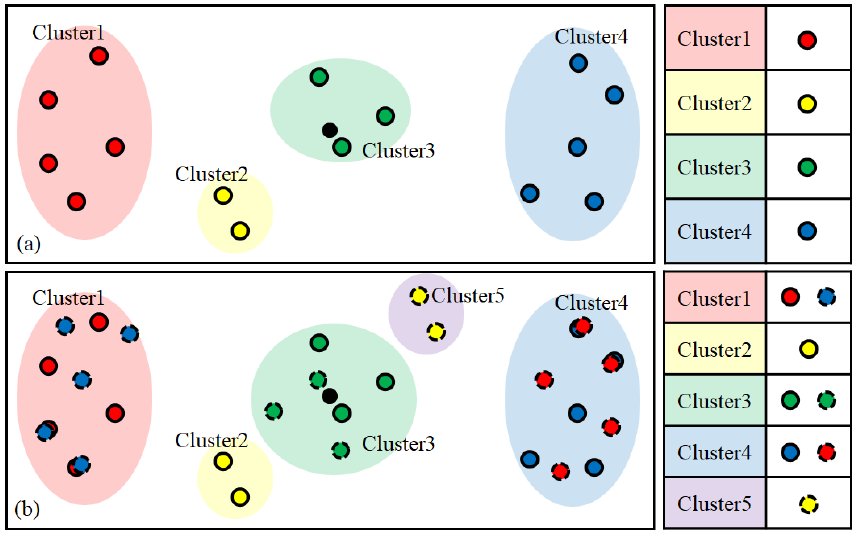
Figure 5. Clustering results of ( a ) original data and ( b ) data including both the original data and symmetric data (dotted circles indicate symmetric data).